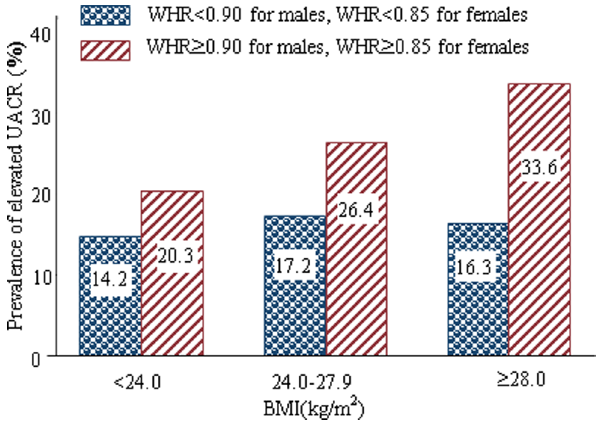
Figure 1. Distribution of elevated urinary albumin-to-creati- nine ratio in obese and/or central obese participants.